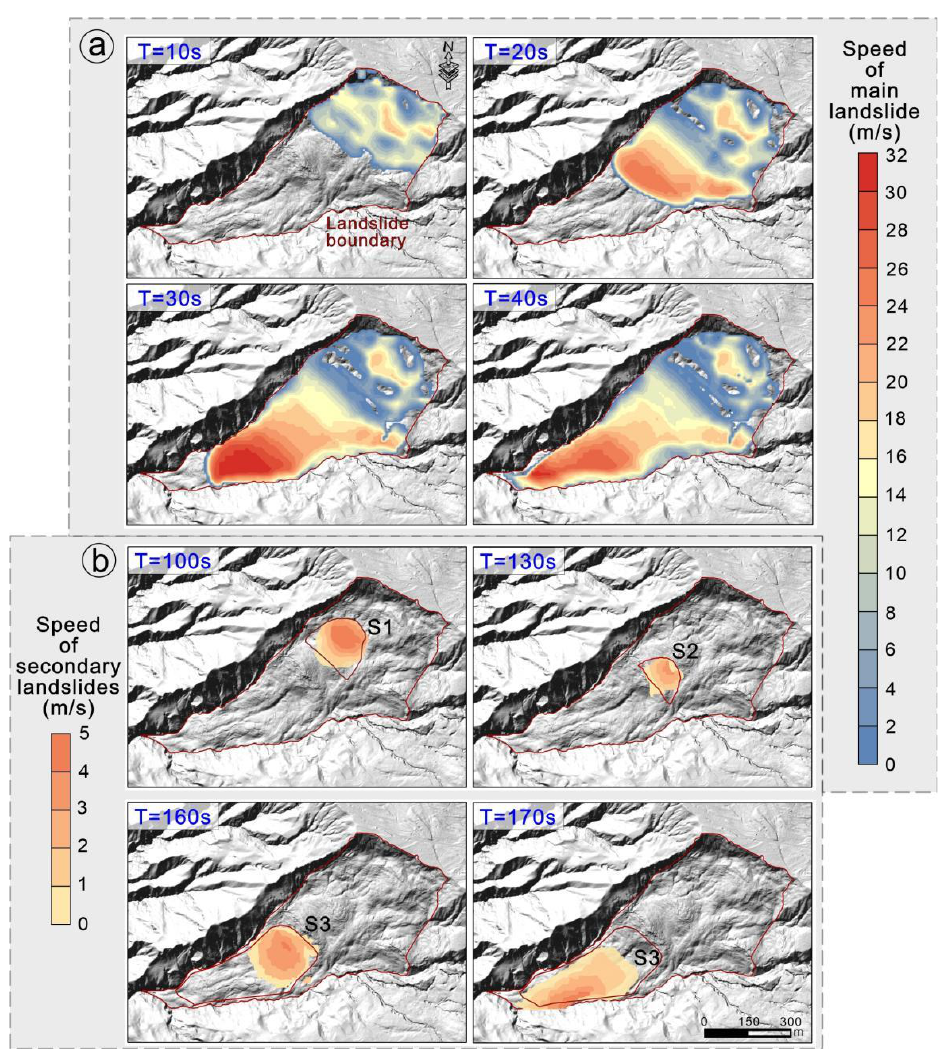
Figure 10. Numerical simulation of landslide movement. ( a ) Main landslide. ( b ) Secondary land- sides.